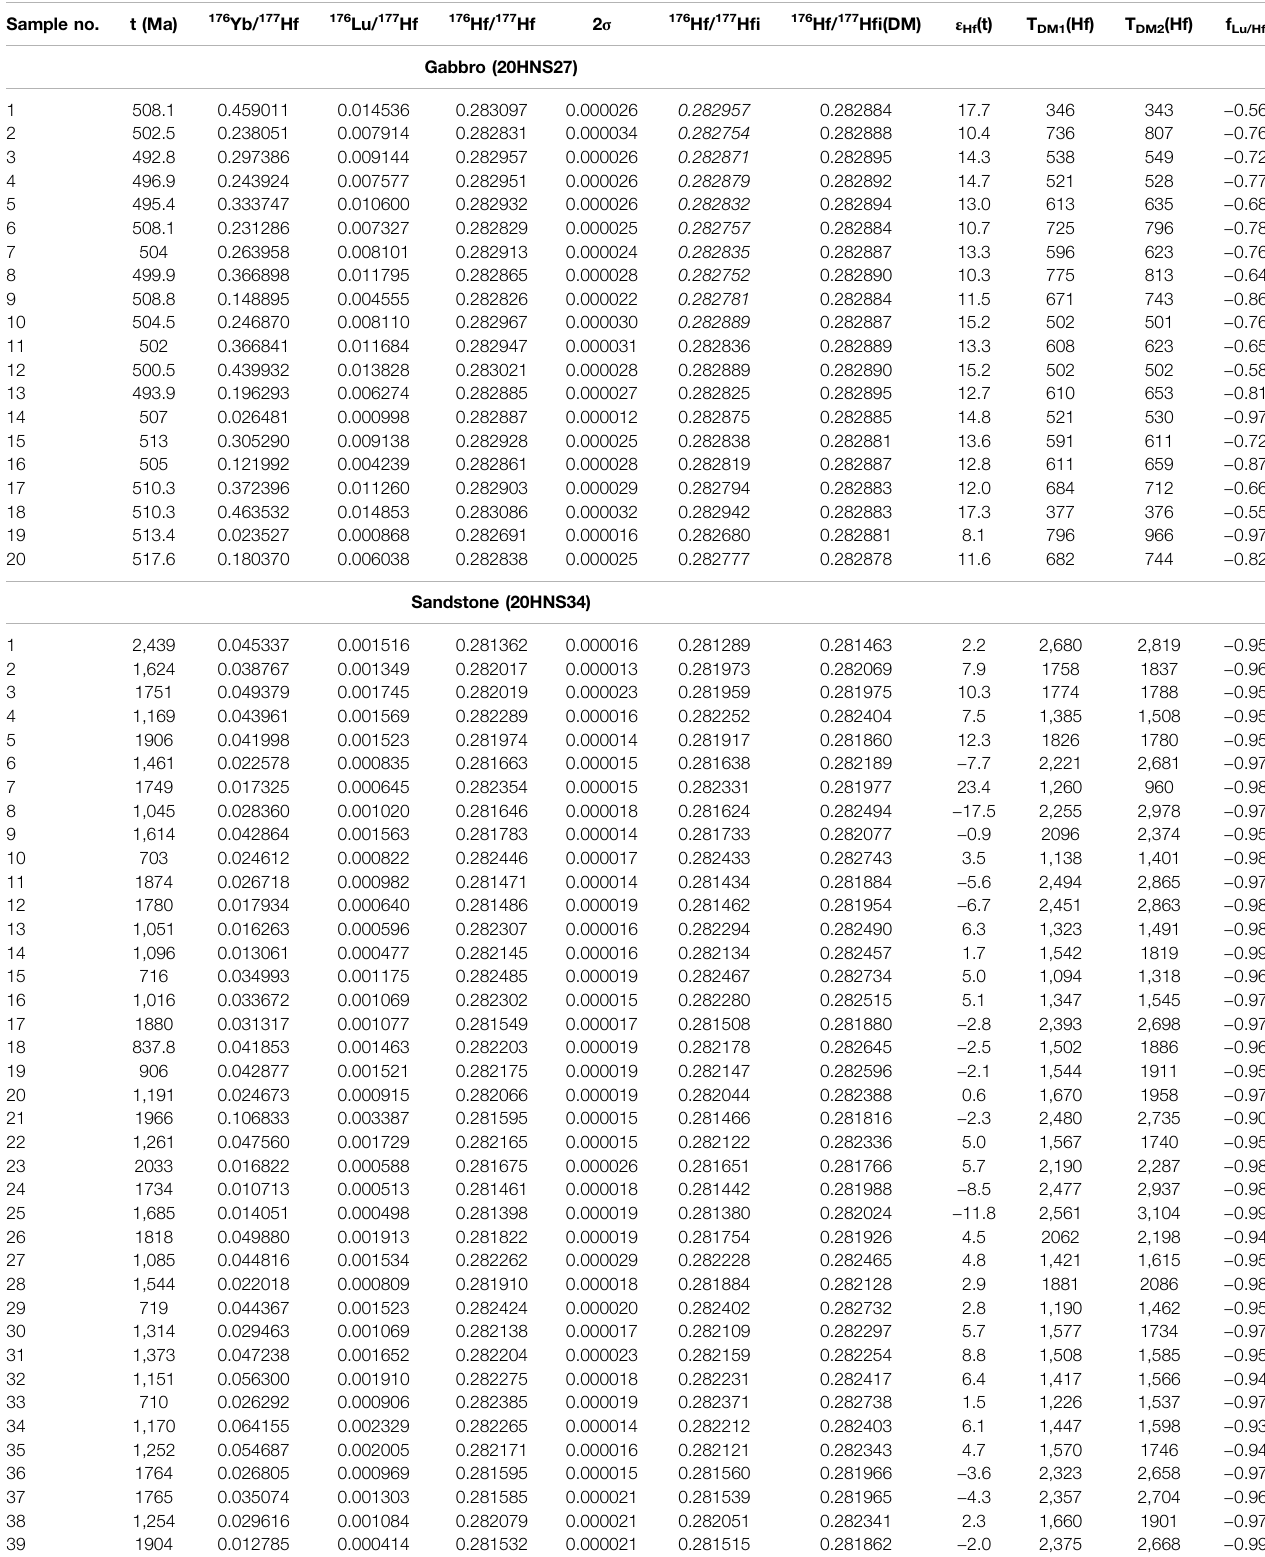
TABLE 2 | Data of zircon Lu-Hf isotopes for the Huaniushan complex in the Beishan orogen. Sample